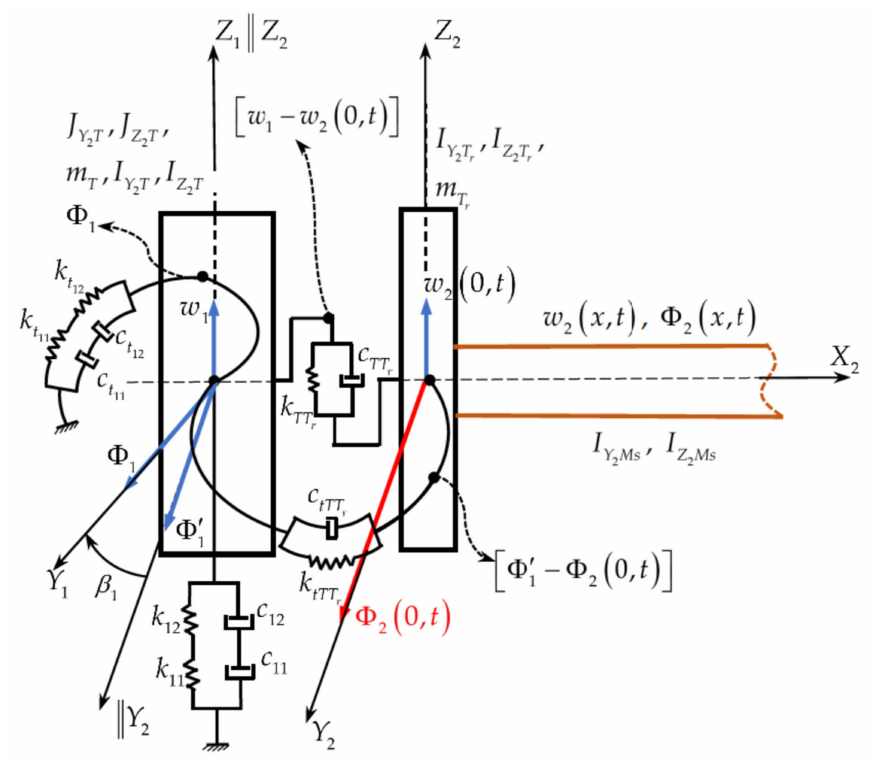
Figure 6. Tulip-tripod joint part of DMFFBV: tulip, tulip-tripod joint, and